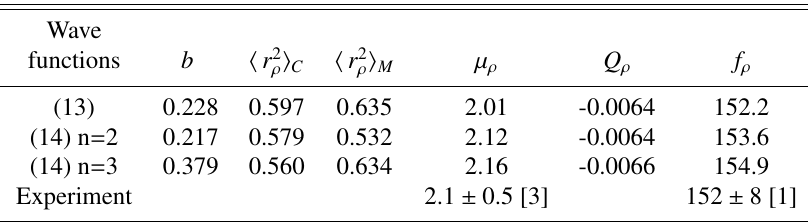
Table 1. The ρ -meson electromagnetic moments and lepton decay constant obtained with the di ff erent model (cid:6) (cid:4) r 2 (cid:6) wave functions (13) – (14). (cid:4) r 2 C , M , are charge and magnetic MSR, respectively, in fm 2 ; μ ρ is relativistic ρ ρ magnetic moment (8) in e / 2 M ρ ; Q ρ is quadrupole moment (9) in fm 2 . The parameters b in (13) and (14) are in GeV, f ρ is ρ -meson lepton decay constant in